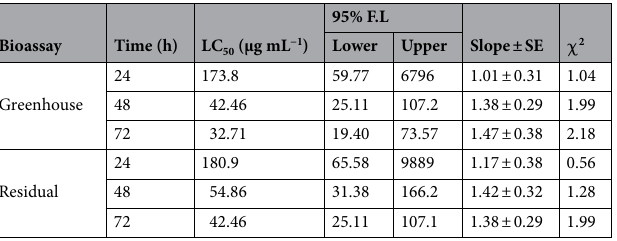
Table 3. Probit analysis of spinasterol and 22,23-dihydrospinasterol against Myzus persicae . F.L. Fiducial limits, χ 2 chi-squared, LC 50 lethal concentration.